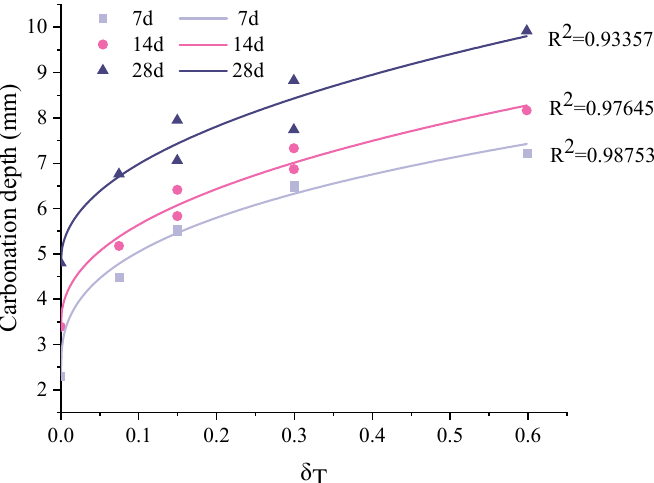
Figure 5. Comparison between the predicted carbonation depth and the experimental results.